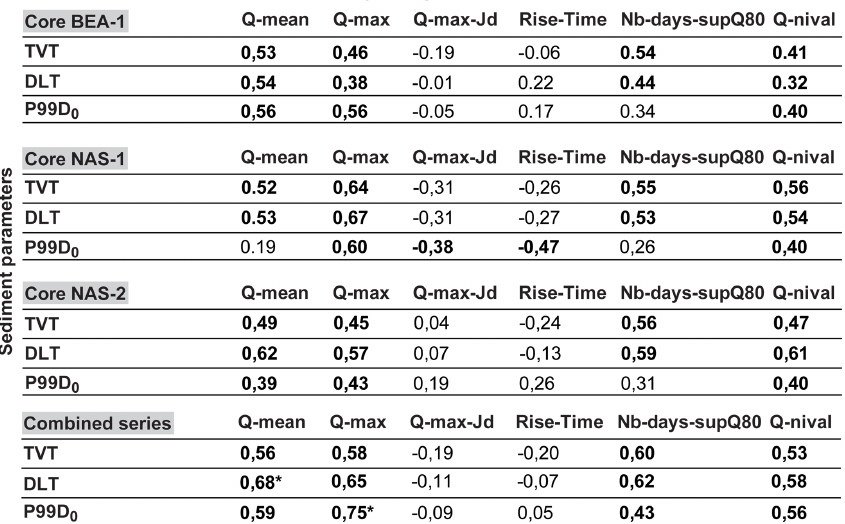
Table 3. Matrix of correlation coefficients (Pearson r ) of the hydrological variables defined in Table 1 with total varve thickness (TVT), detrital layer thickness (DLT) and particle size (P99D 0 ) for the instrumental period (1978–2011; n = 31) for each core. Correlations between the hydrological variables and the combined TVT, DLT and P99D 0 series (normalized and averaged varve parameters of cores BEA, NAS-1 and NAS-2) are also present. Correlations in boldface are significant at p< 0 . 05 (Supplement Table S4). Correlations marked by an asterisk were used for the final Q -mean and Q -max